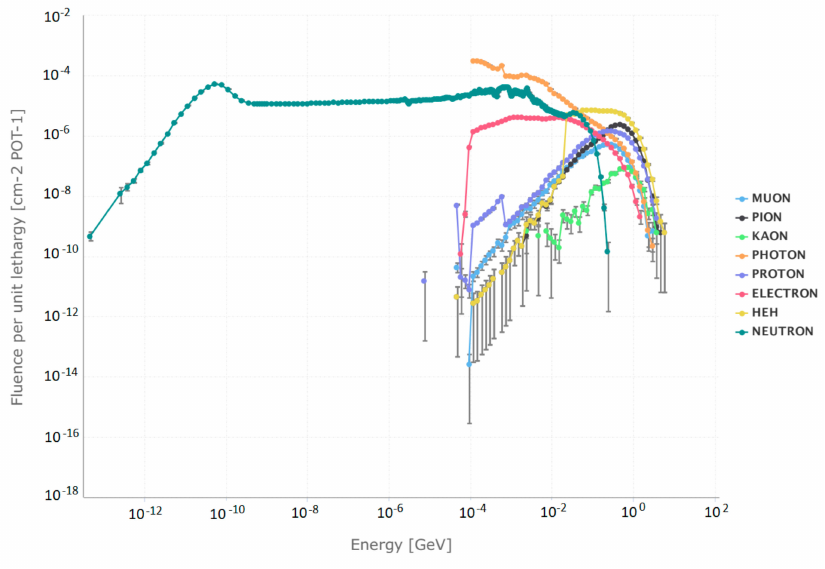
Figure 3. Spectra at position PC0 with copper target and no additional